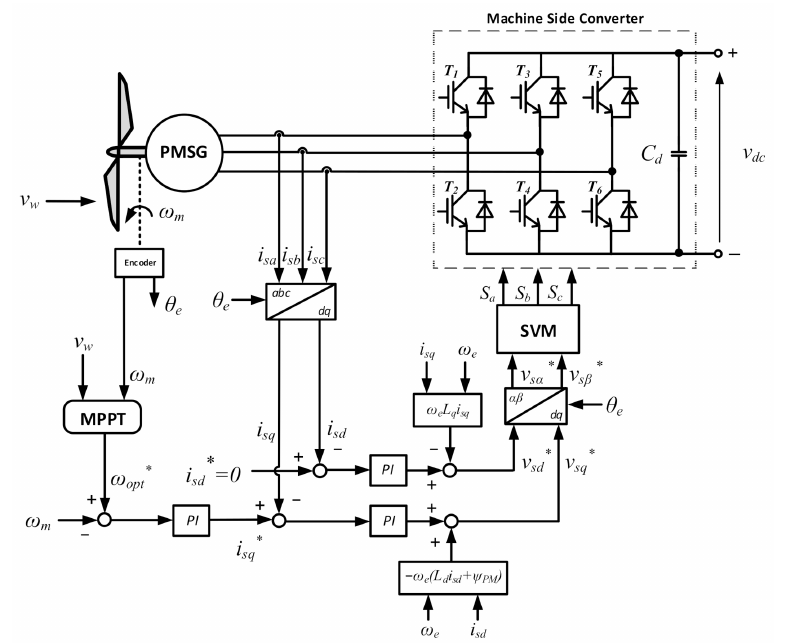
Figure 13. Control diagram of Rotor Field Oriented Control for Permanent Magnet Synchronous Generator (PMSG) with